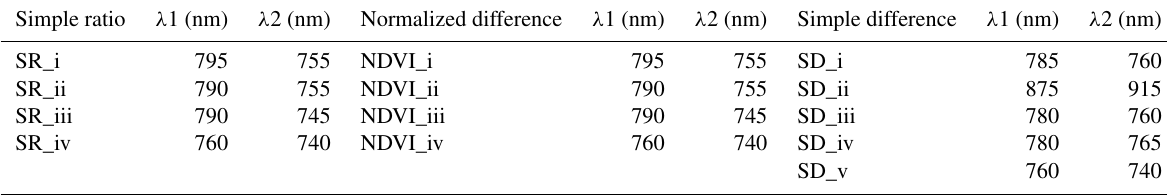
Table 5. Generated optimized indices for different plant traits and their wavelength dependency. Simple ratio